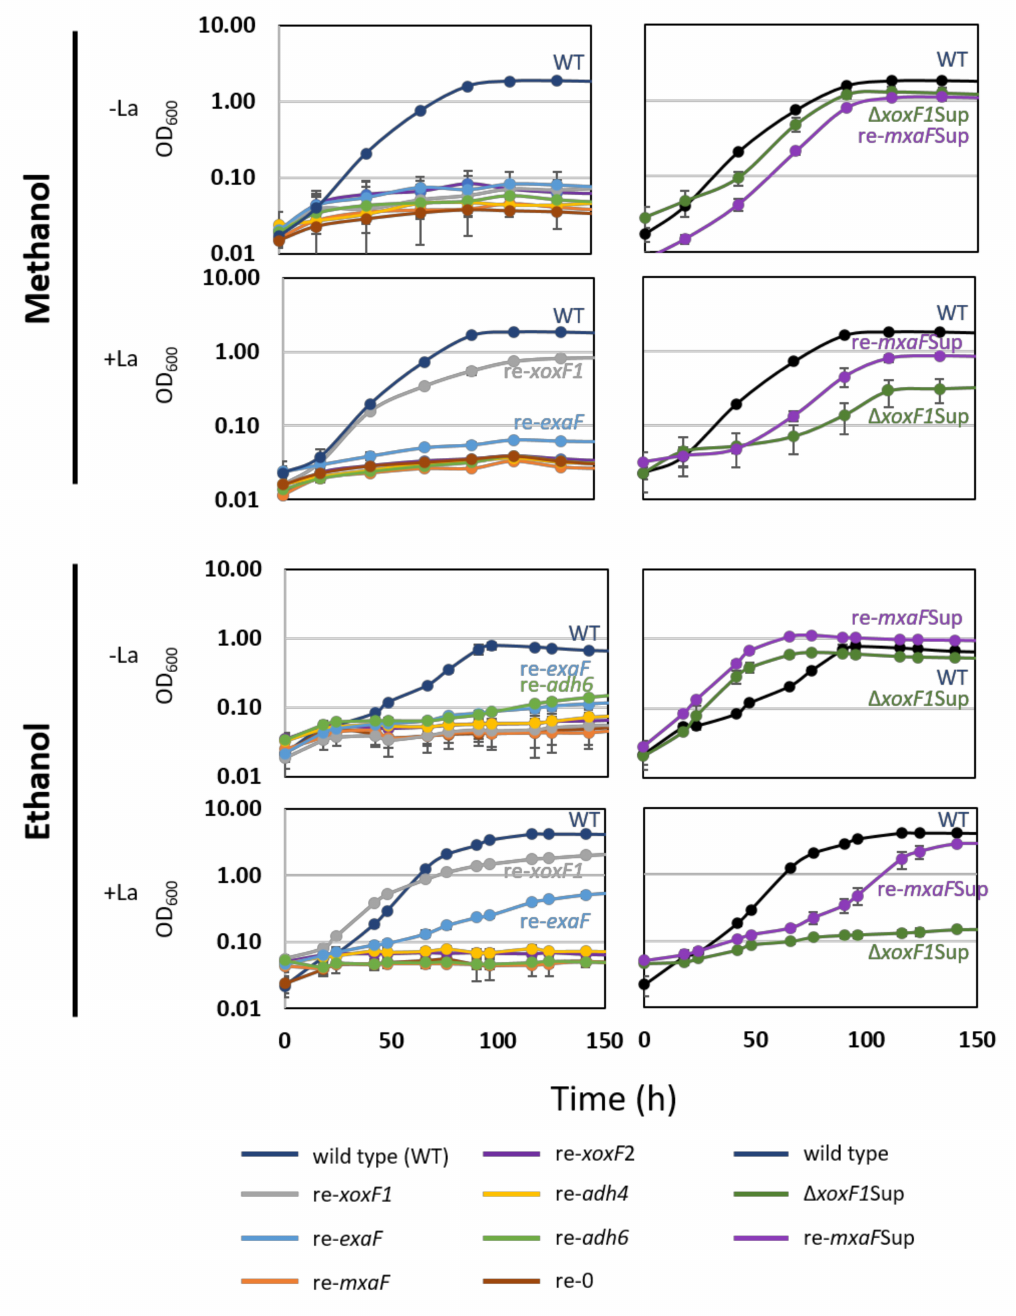
Figure 3. Left panel, growth of single-gene-remaining mutants of MDH-like genes and a mutant without any MDH-like gene (re-0). Right panel, growth of the suppression mutants. Cultivation was done in 96-well plates under shaking at 300 rpm. The results are presented as the average ± SD (technical